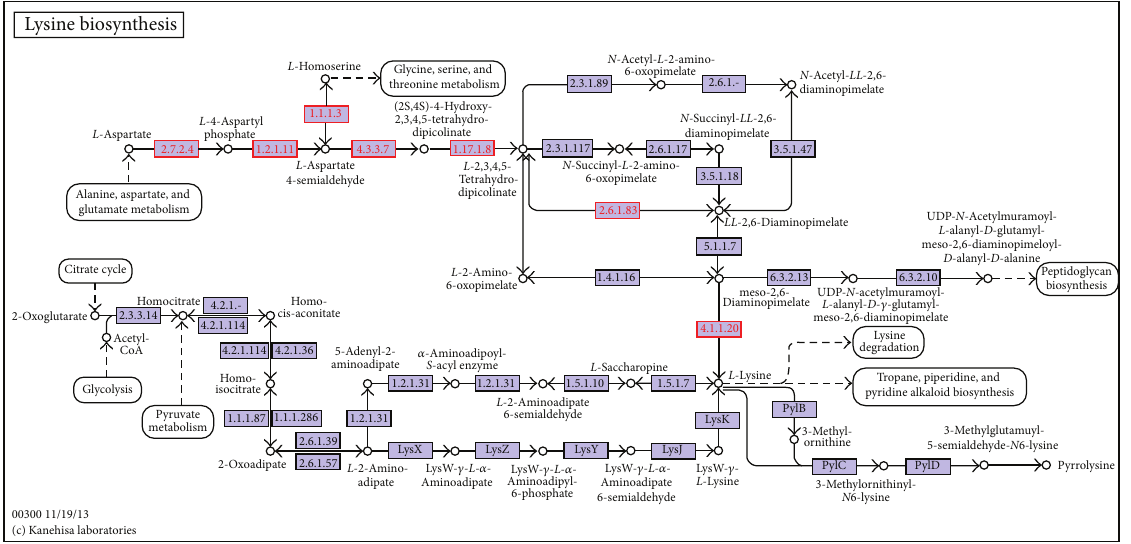
Figure 4: The lysine biosynthesis in T. sinensis . Note: The red dots represent upregulated DEGs in XC- L -4; the purple dots represent not